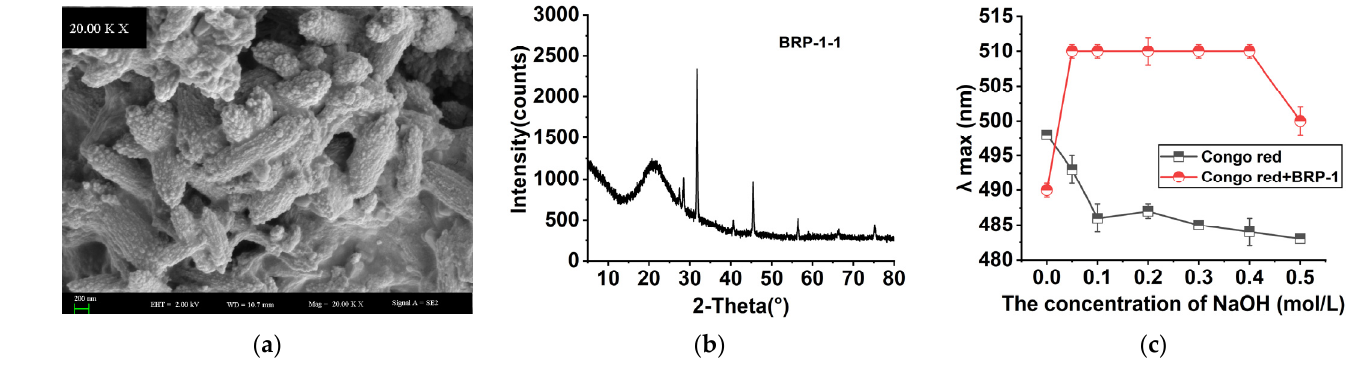
Figure 5. ( a ) SEM of BRP-1-1 observed at 20 KX; ( b ) XRD characterization of BRP-1-1; ( c ) variation curves of λ max of Congo red + BRP-1-1 and Congo red solution.